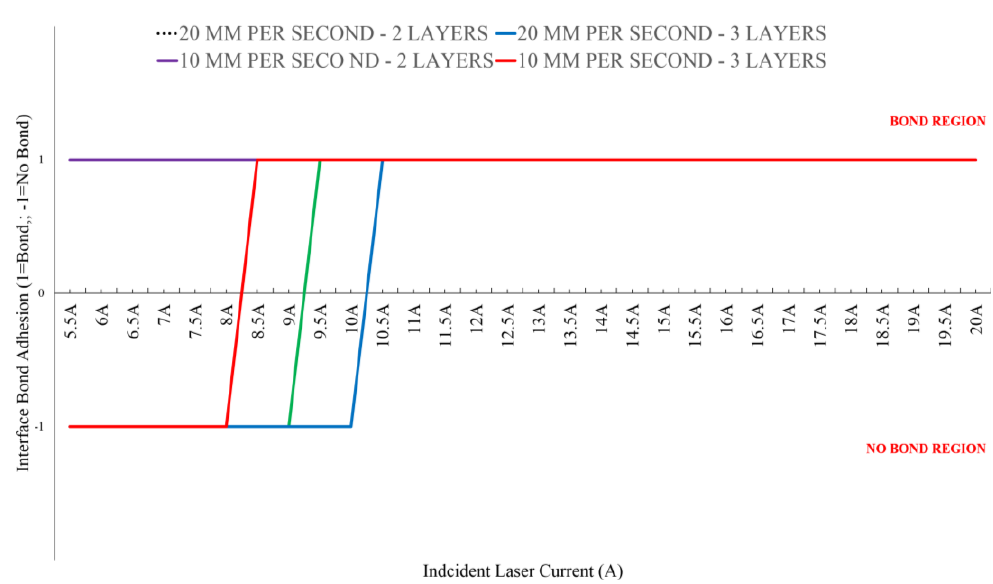
Figure 13. Shear and Bond Zone comparisons of 10 and 20 mm/s cross-head speeds at variable incident laser current (A).